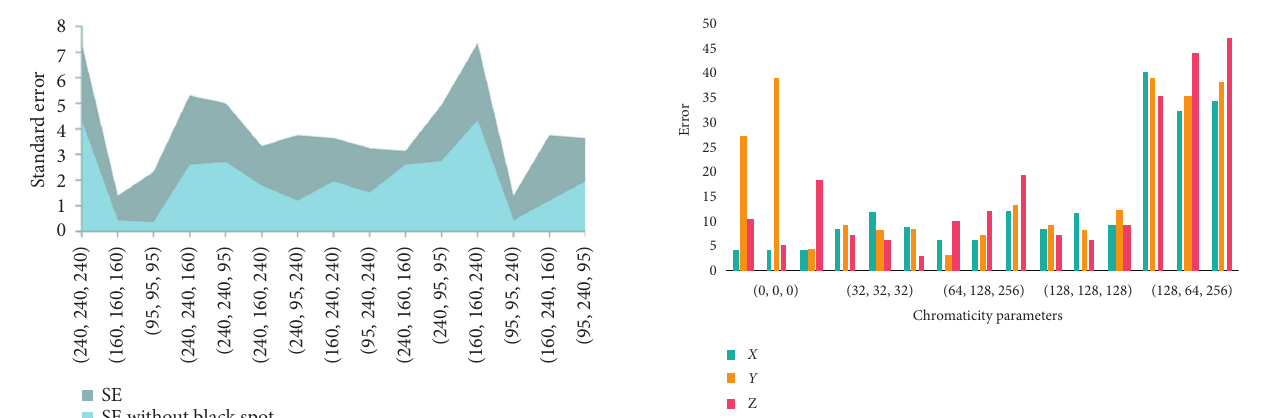
Figure 8: Chromaticity parameters when the same color block is in different positions on the screen.